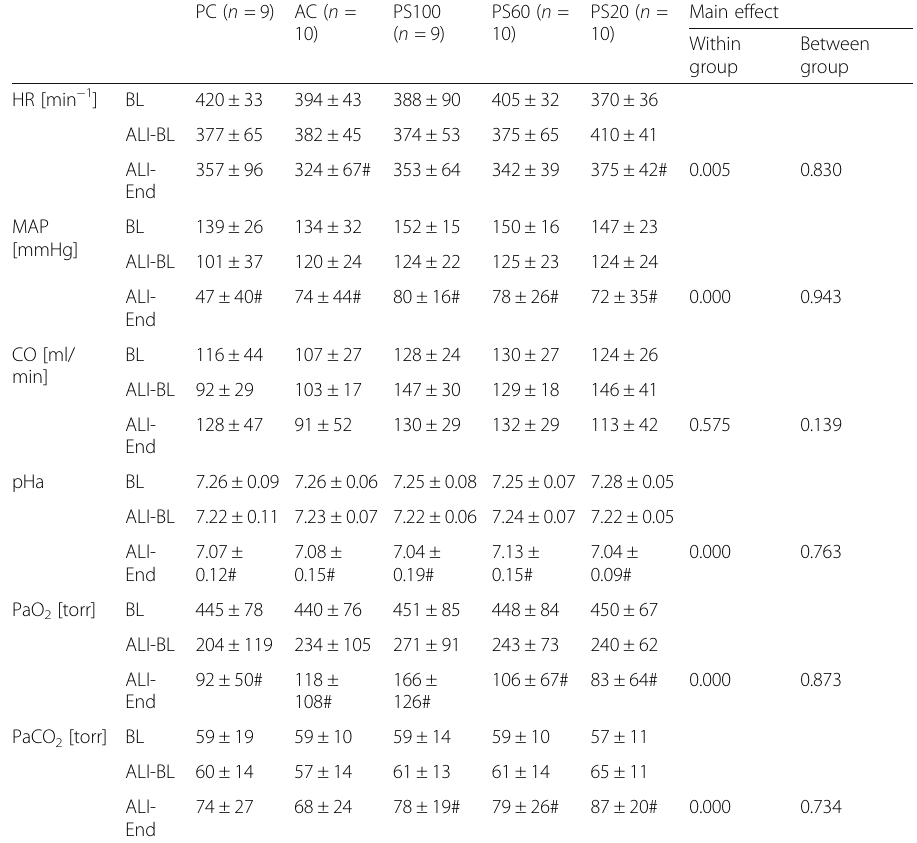
Table 2 Hemodynamics and gas